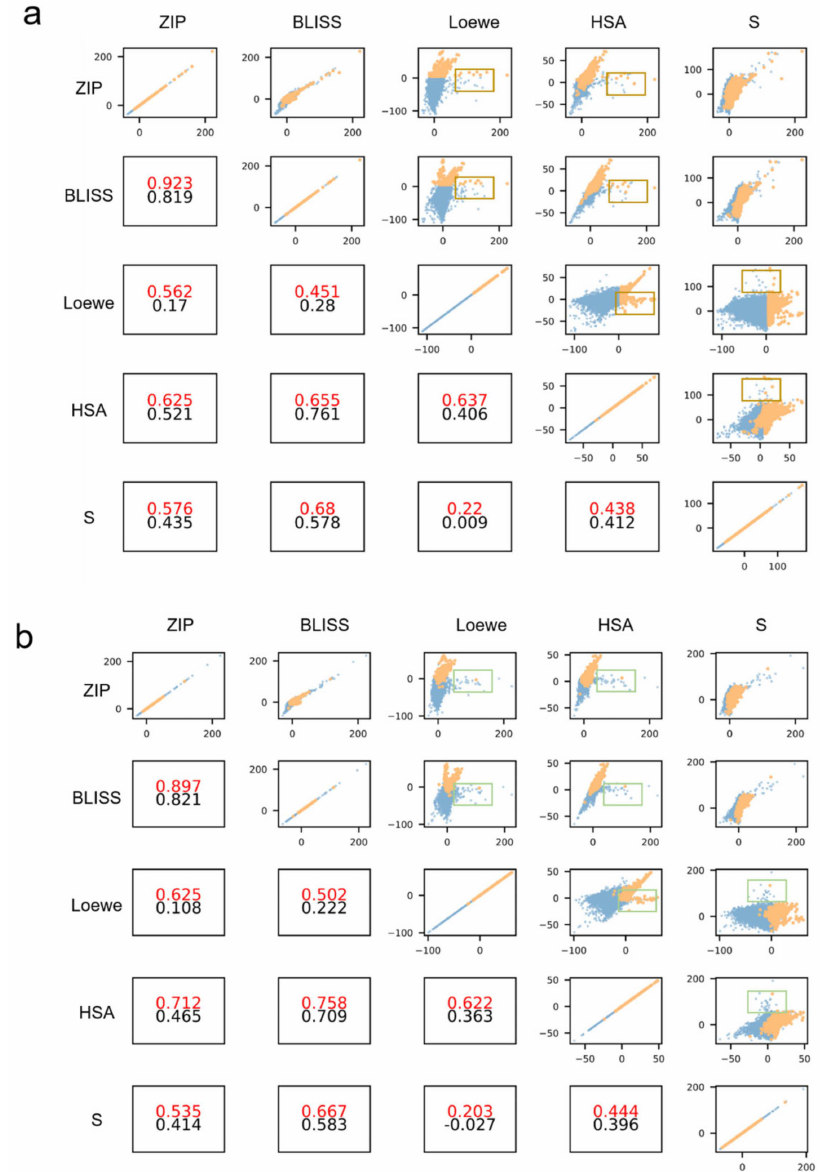
Figure 7. ( a ) The correlation between the different pairs of actual synergy scores. The yellow points represent the synergistic samples labeled by the actual Loewe score and the blue points represent the non-synergistic samples. ( b ) The correlation between the different pairs of predictive synergy scores. The yellow points represent the synergistic samples predicted by